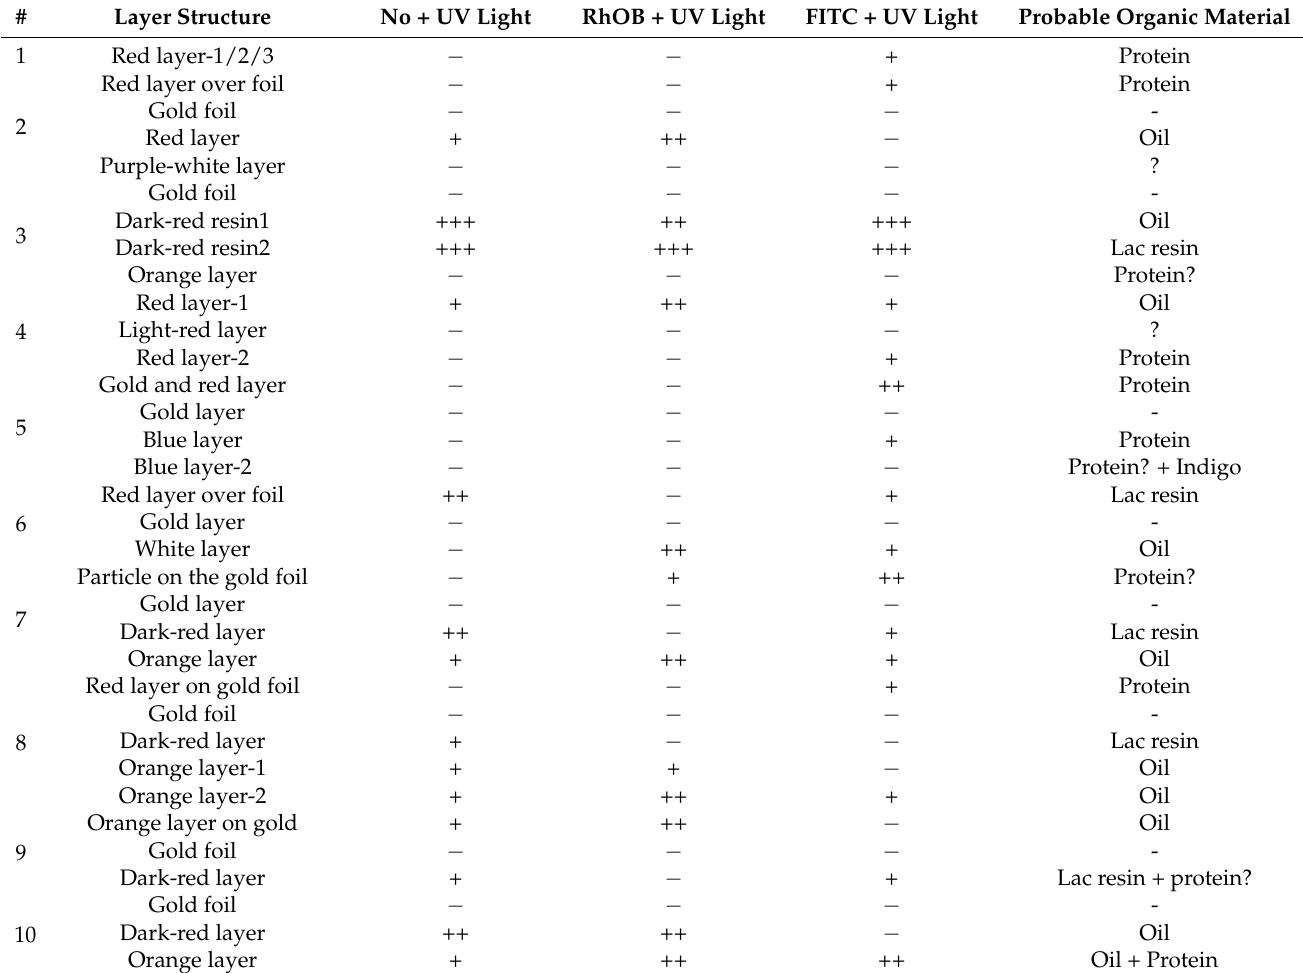
Table 4. Positive fluorescence reaction results with the possible use of organic material in each